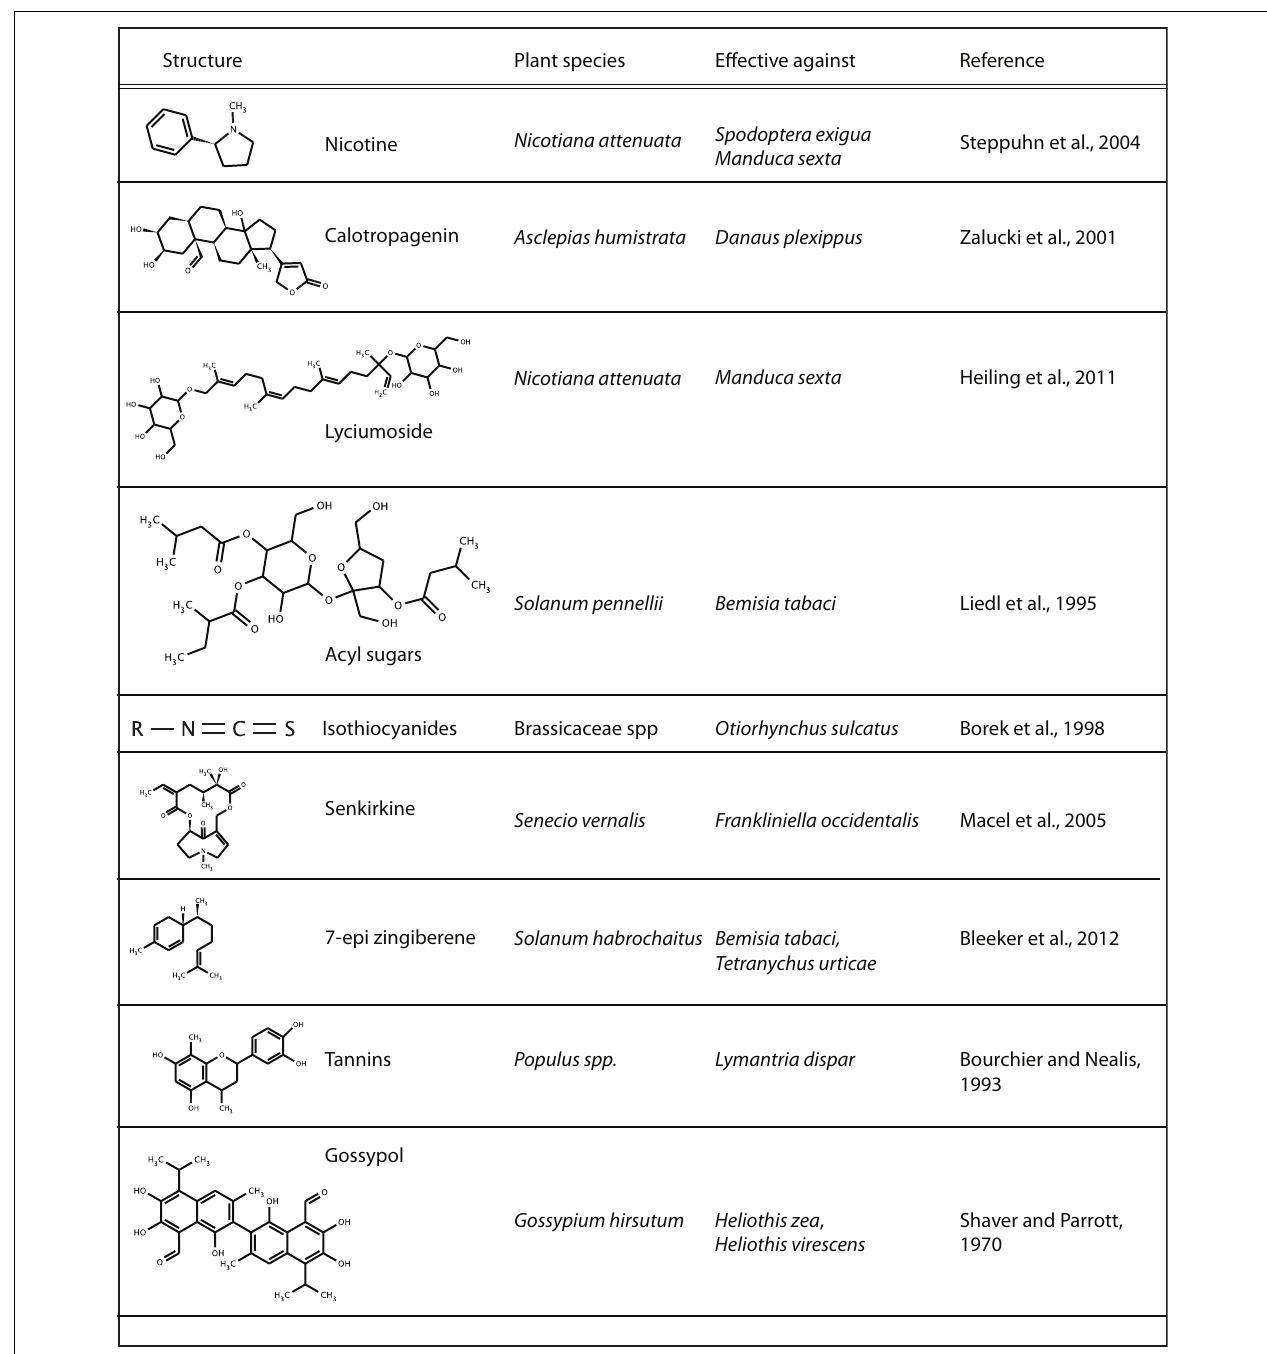
FIGURE 1 | Overview of insecticidal secondary metabolites and their plant